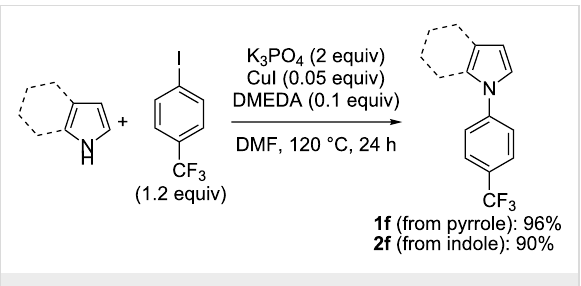
Scheme 1: Synthesis of the azole substrates 1f and 2f